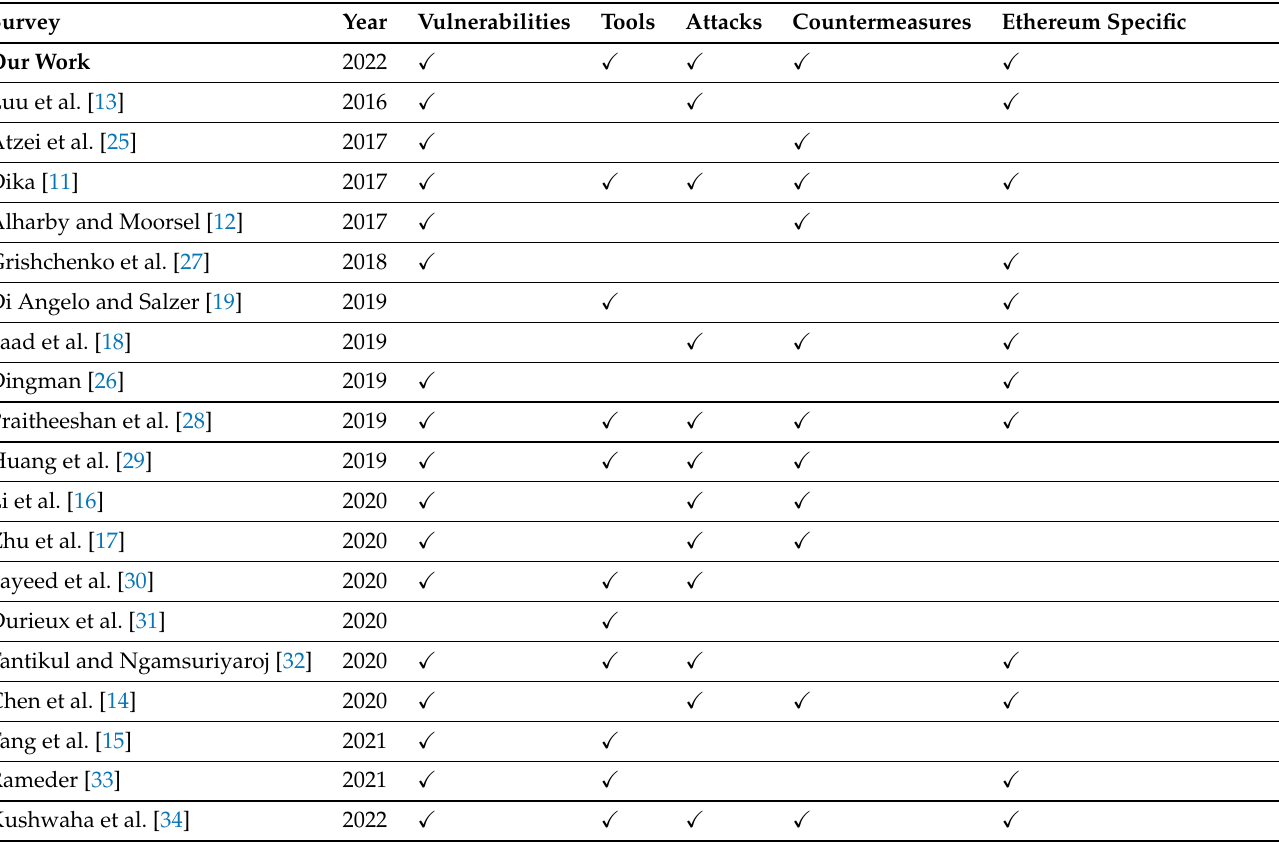
Table 1. Comparison between the existing surveys on smart contract vulnerabilities and our